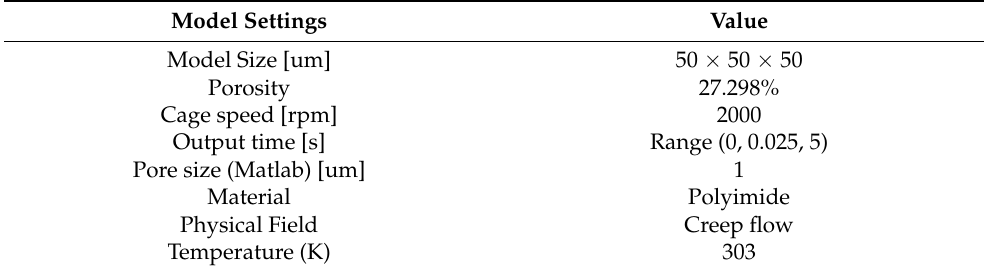
Table 3. The input of the simulation.